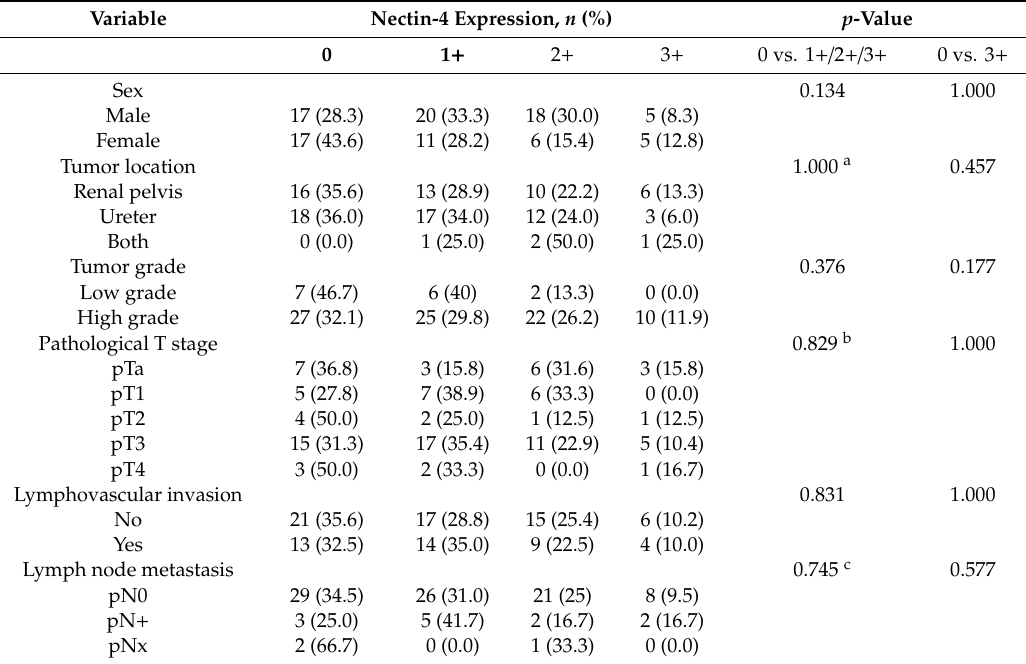
Table 2. Association of Nectin-4 expression with clinicopathological characteristics of UTUC. Variable Nectin-4 Expression, n (%) p